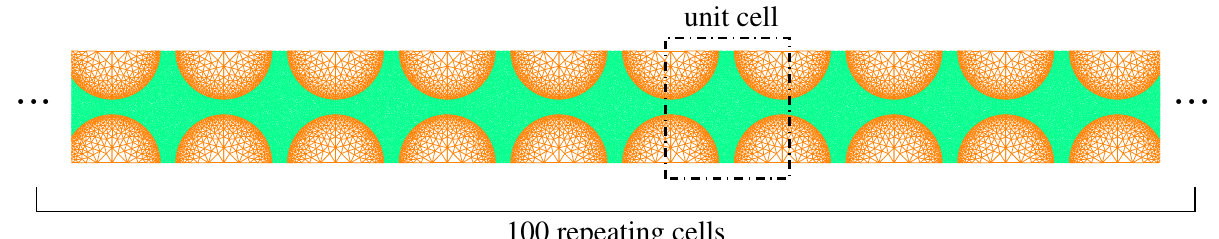
Figure 15. The DNS model mesh of a composite structure consisting of 100 repeating unit microstructure cell. There are two phases of materials, circular inclusions with a diameter of 0.5 mm and a surrounding matrix [78].